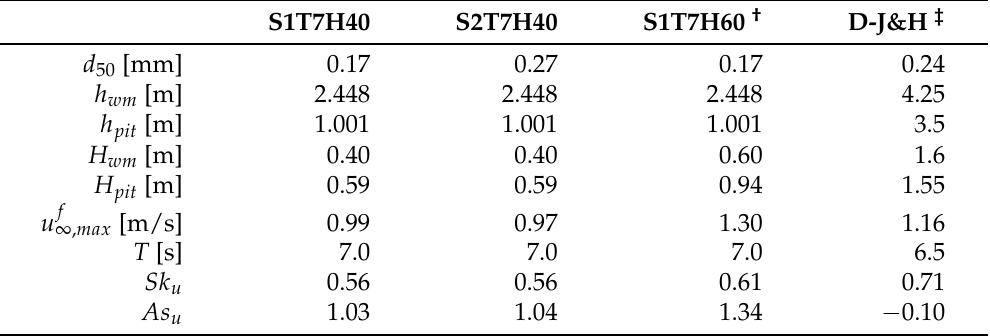
Table 1. A summary of physical parameters and wave conditions for four different SedWaveFoam wave flume